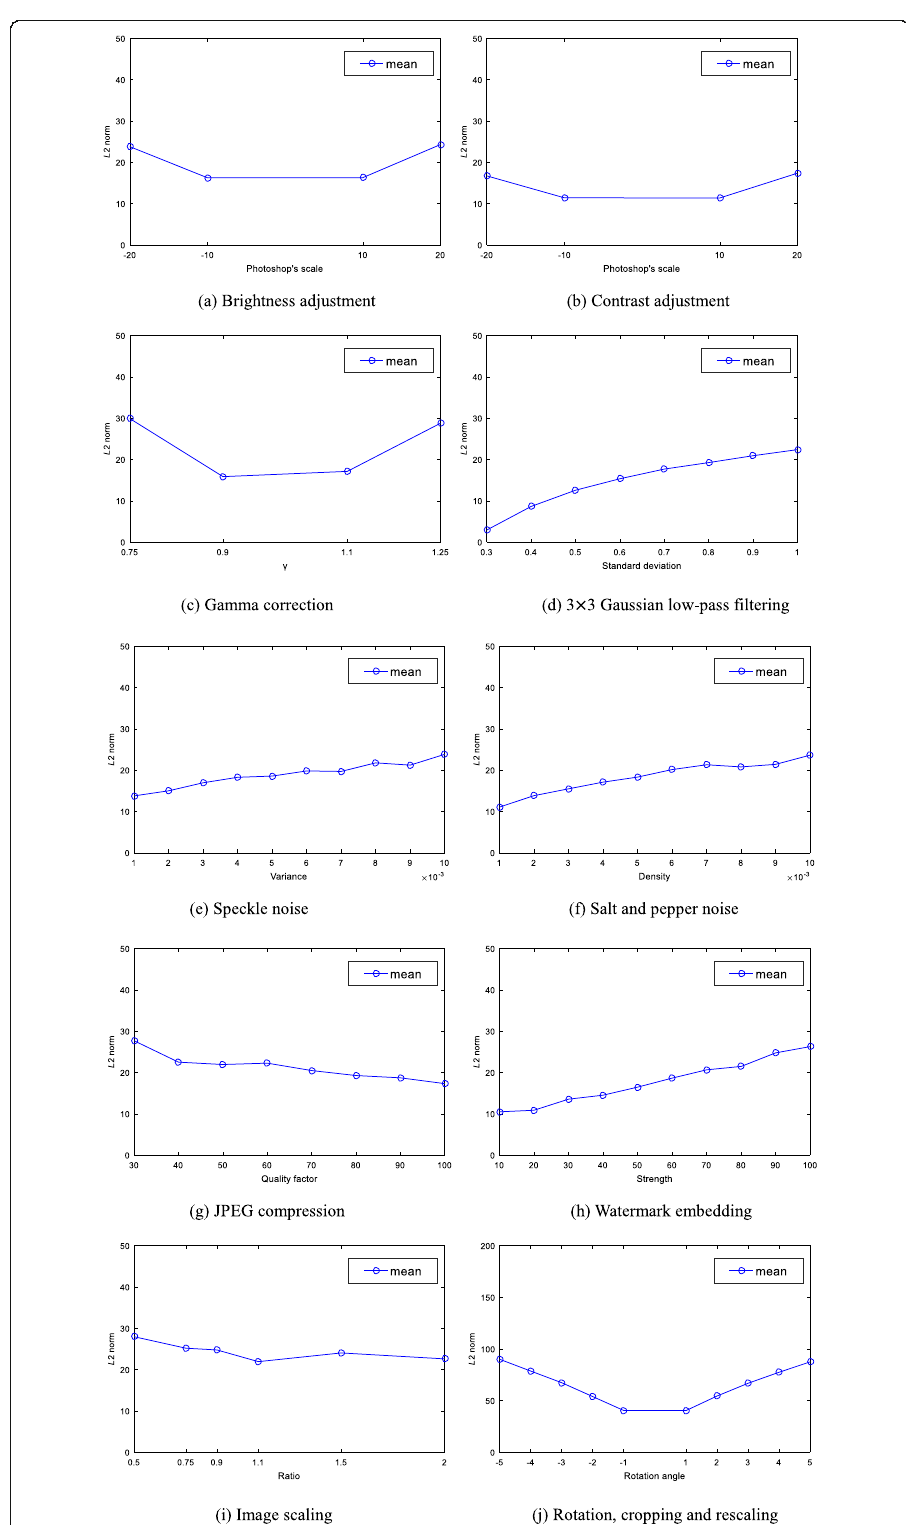
Fig. 5 Robustness results on Kodak